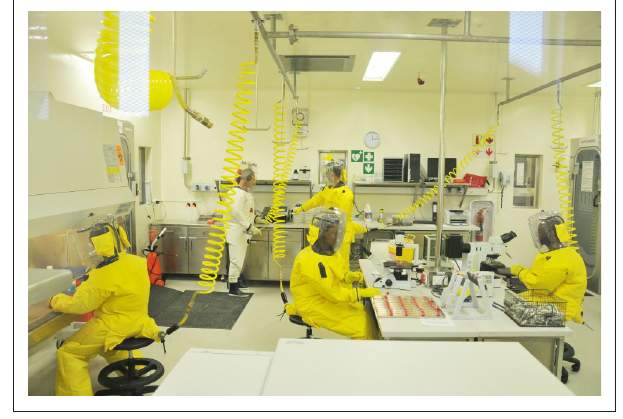
Source : Photograph provided by authors FIGURE 2: Dissection of wild-caught bats. Field laboratory deployed during Ebola ecology study in Luebo, Democratic Republic of the Congo, May 2011.